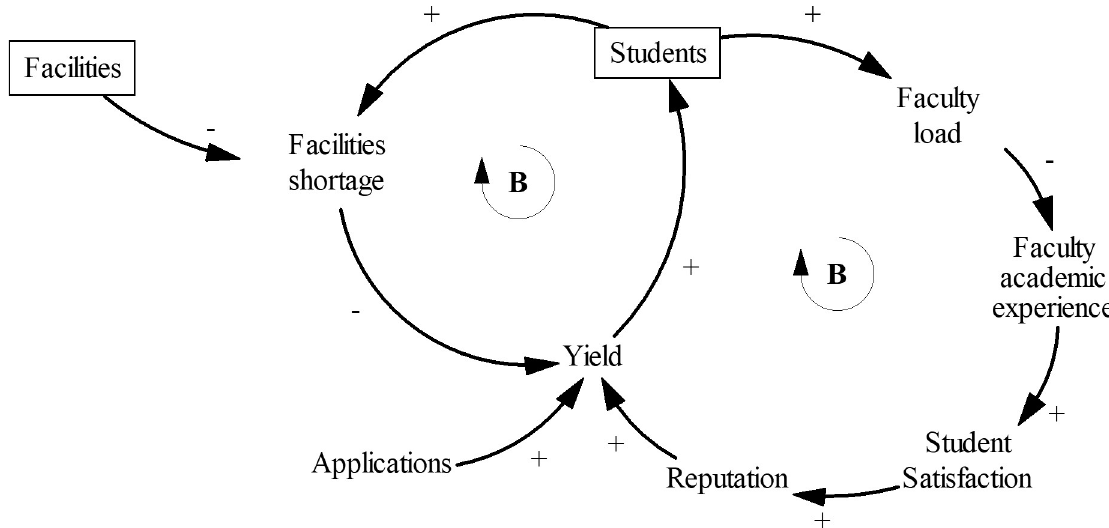
Fig 2. Causal structure of the Students sector. Rectangles indicate stocks. Arrows show direction and polarity of causal relationships. The letter B signifies balancing loops.